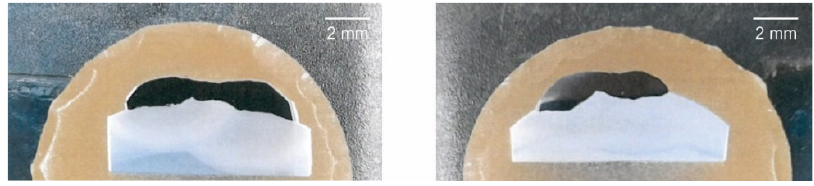
Figure 7. Appearance of some of the metallographic ground samples.